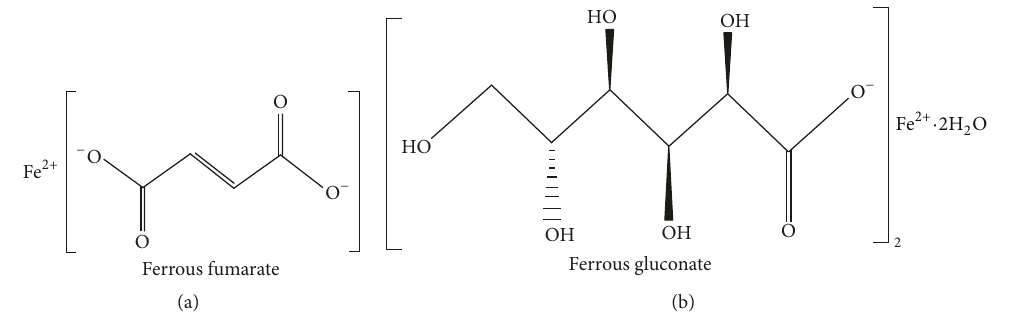
Figure 1: Chemical structure of (a) ferrous fumarate and (b) ferrous gluconate [8].